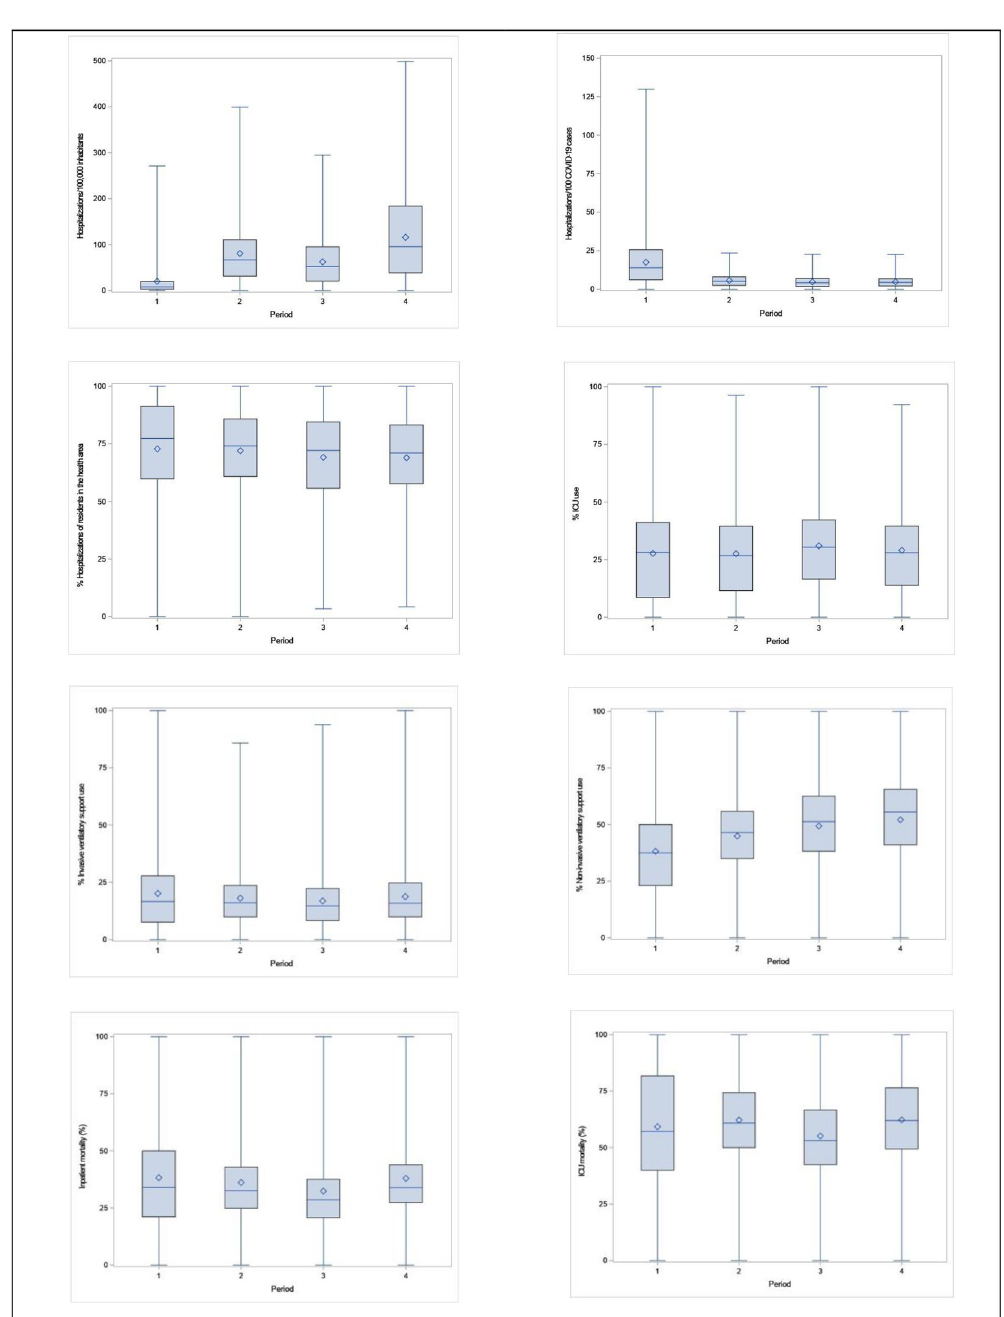
Fig 1. Box-plots of variables related to the occurrence of COVID-19 hospitalizations and inpatient care process and outcomes in the administrative Health Regions. Brazil, epidemiological weeks 09/2020–11/2021, 23 Feb 2020–20 Mar 2021. Sources: SIVEP-Gripe, Minister of Health, Brazil; and Brasil.io. From left to right, top to bottom: COVID-19 hospitalizations per 100,000 inhabitants; COVID-19 hospitalizations per 100 new COVID-19 cases; Proportion of hospitalizations of residents in the Health Area; Proportion of hospitalizations with ICU use; Proportion of hospitalizations with invasive ventilatory support; Proportion of hospitalizations with non-invasive ventilatory support; Proportion of hospitalizations resulting in death; Proportion of hospitalizations with ICU use resulting in death. Periods: 1, epidemiological weeks 09-22/ 2020 (23 Feb 2020–30 May 2020); 2, epidemiological weeks 23-36/2020 (31 May 2020–05 Sep 2020); 3, epidemiological weeks 37-50/2020 (06 Sep 2020–12 Dec 2021); and 4, epidemiological weeks 51/2020–11/2021 (13 Dec 2021–20 Mar